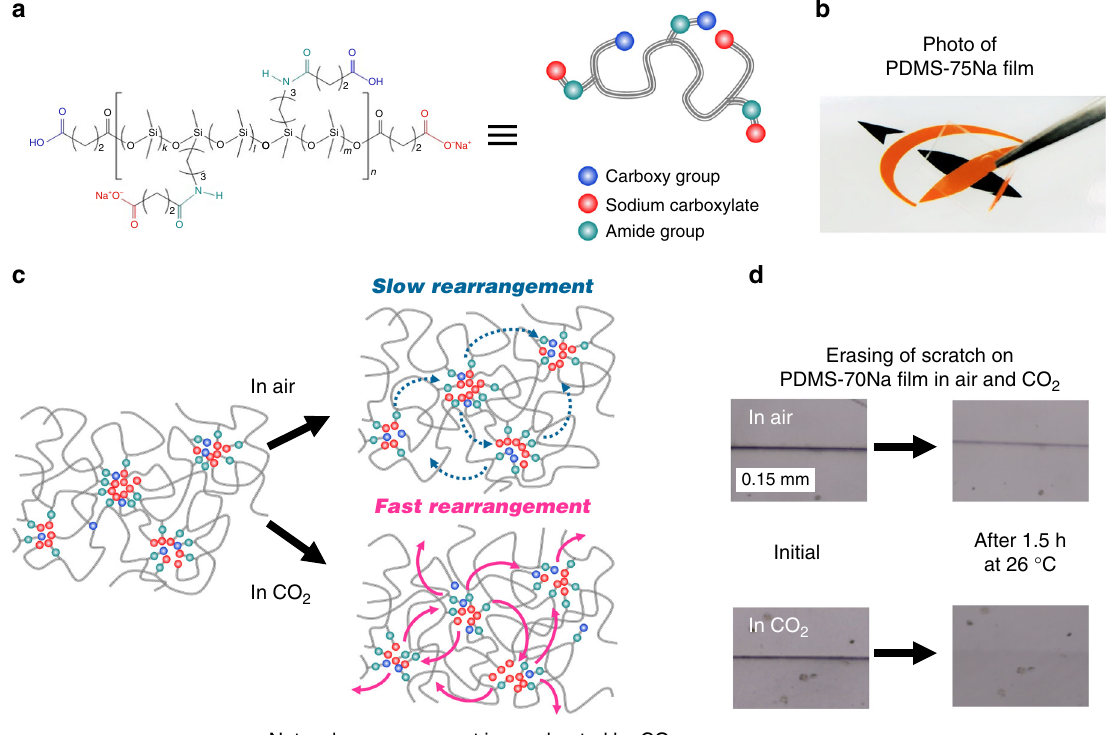
Fig. 1 Molecular structure and network rearrangement chemistry of PDMS- x Na. a Chemical structure and schematic illustration of PDMS- x Na. b Photograph of a transparent and colorless PDMS-75Na fi lm. c Schematic illustration for slow and fast rearrangement of ionic crosslinks in air and CO 2 , respectively. Plasticization of ionic aggregate by CO 2 gas provides rapid network rearrangement. d Optical microscopic images of a razor scratch on a PDMS-70Na fi lm surface healed at 26 °C for 1.5 h in air and in CO